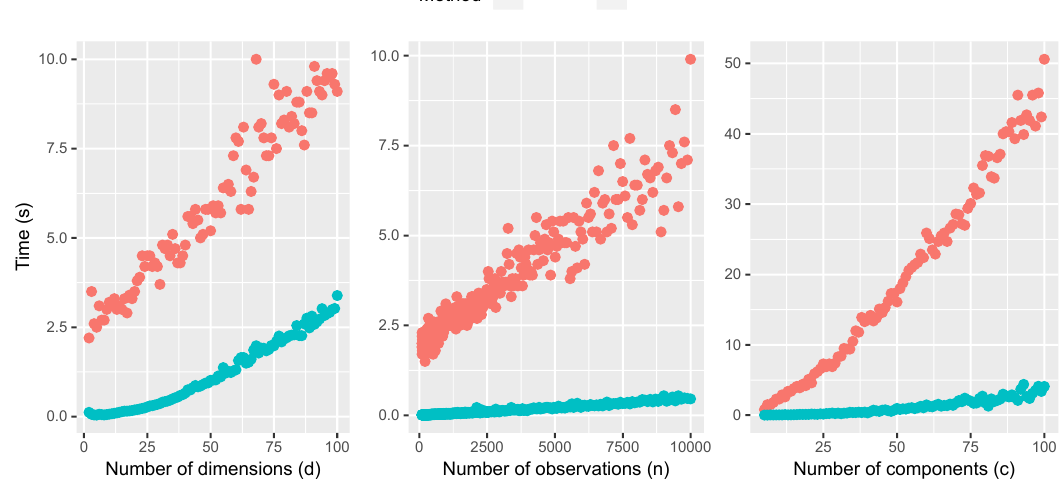
Figure 13. Time complexity of REBMIX algorithm vs. k -means